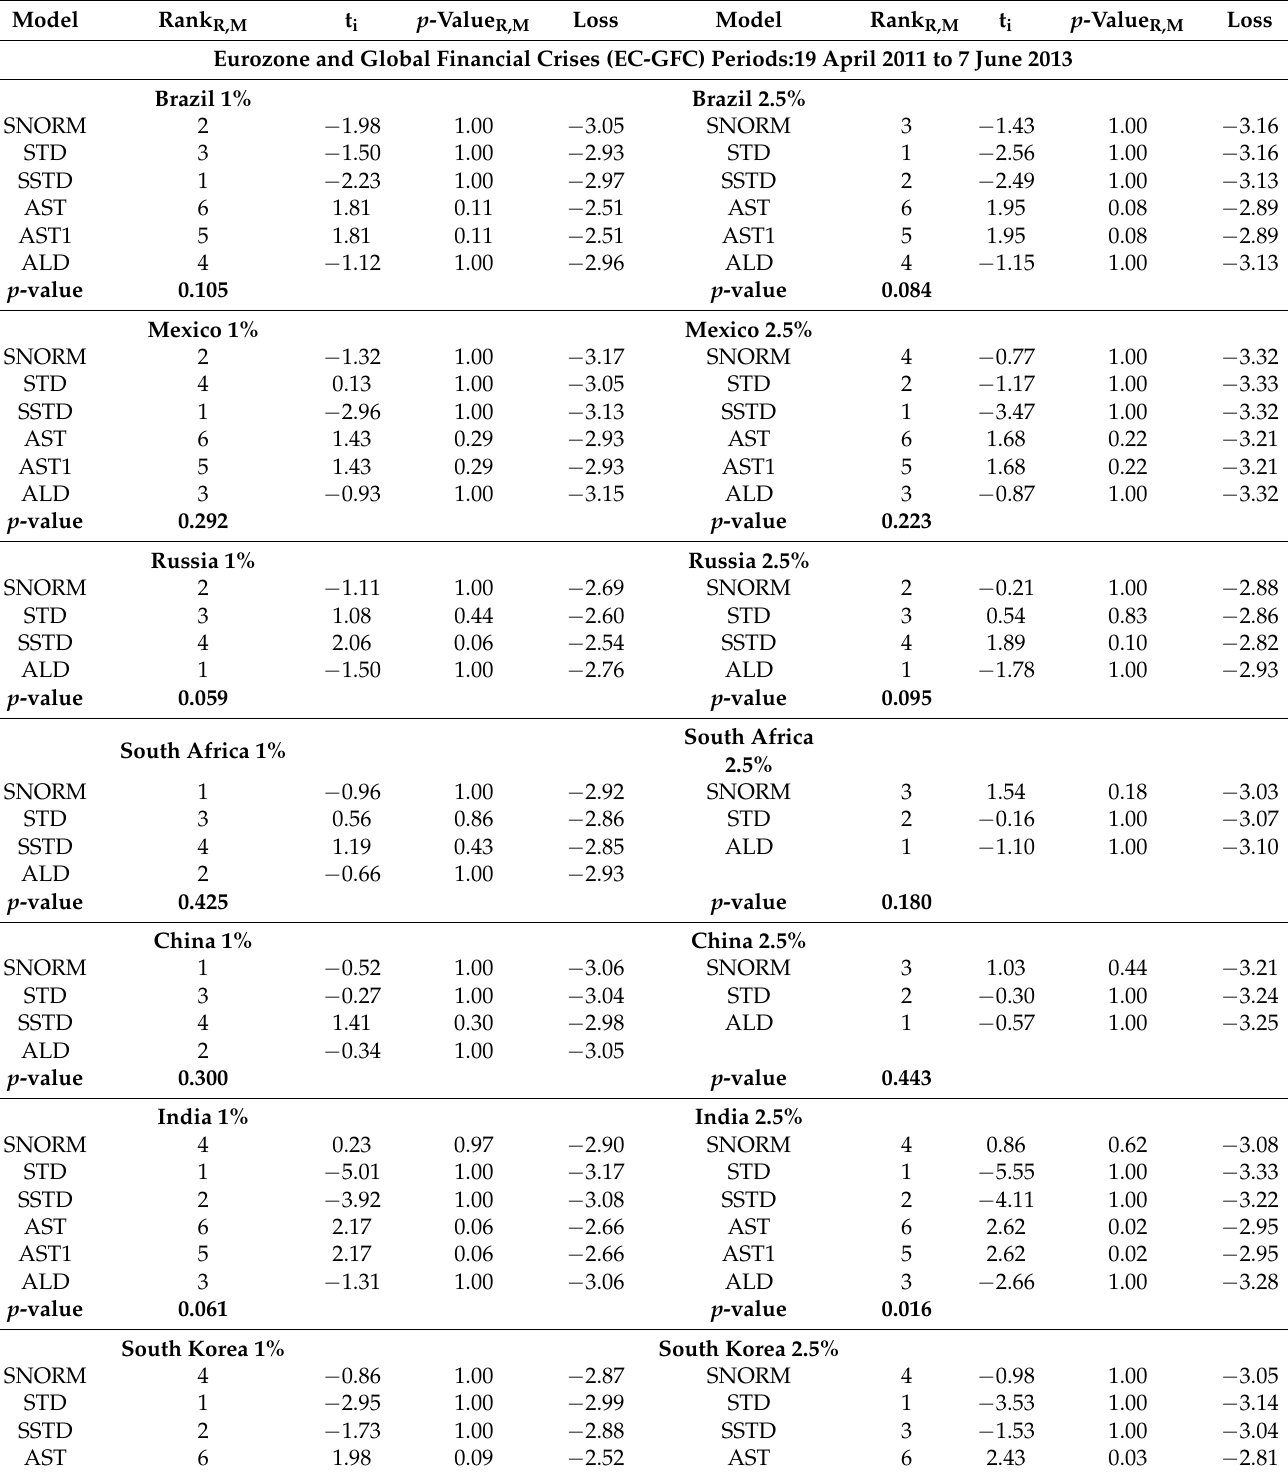
Table 3. SSM of univariate GAS (VaR, ES) model forecasts per